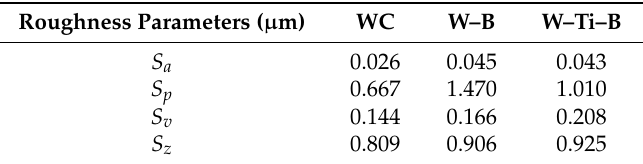
Table 3. Surface roughness parameters without filtration.